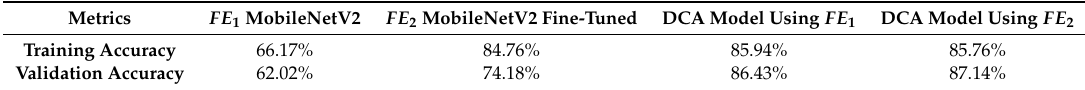
Table 1. Dynamic collision avoidance models’ comparison